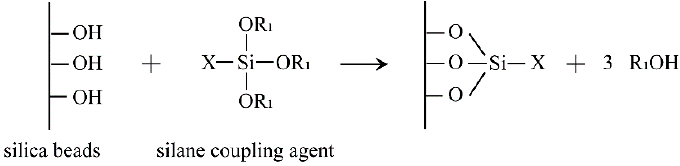
Figure 3. The C 1s , O 1s , N 1s and Si 2p core level spectra of ( a ) untreated silica beads, ( b ) AEAPTES-silica beads, ( c ) GOPTES-silica beads, ( d ) EDTA-silica beads, and ( e ) 0.6KPEI-silica beads.